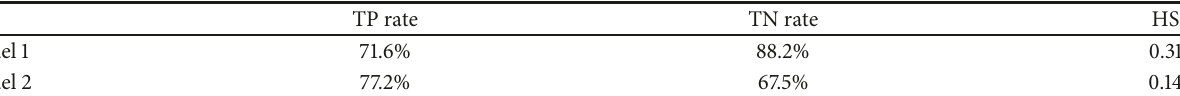
Table 5: Performances of solar flare forecasting